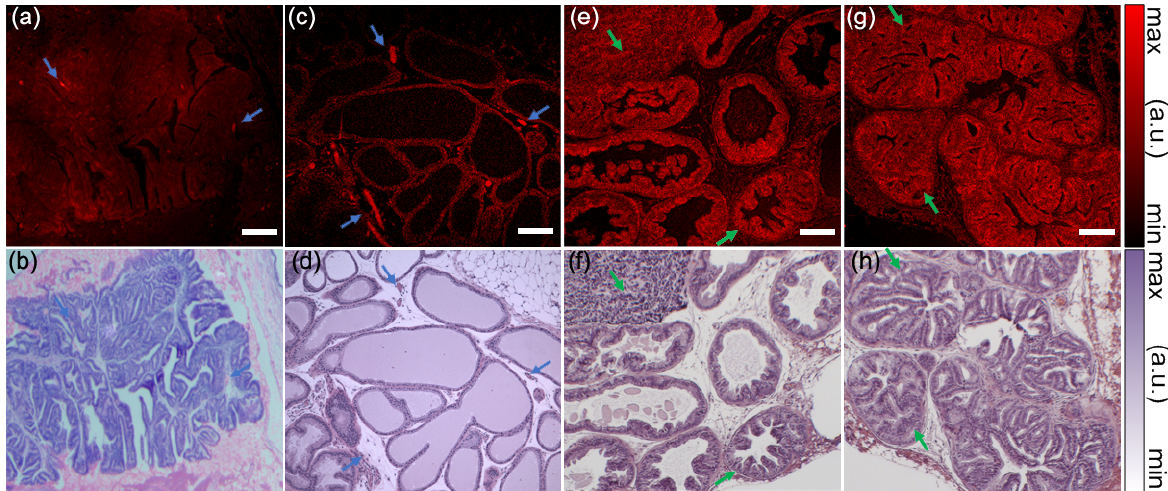
Figure 4. Microarchitectures of PCa in TRAMP mice labeled in vivo by F3-conjugated PAA NPs loaded with fluorescent MB dye. The top row shows the fluorescence images, and the bottom row shows the paired H&E stained histology images. ( a , b ) Cancerous prostate without NP injections. ( c , d ) Normal prostate with NP injection. ( e – h ) Cancerous prostates, both with NP injections. The blue arrows mark the red blood cells with auto-fluorescence. The green arrows correspond to the glandular microarchitectures at progressive cancer stages. Images are taken at 10 × magnification. Scale bar: 100 µm.